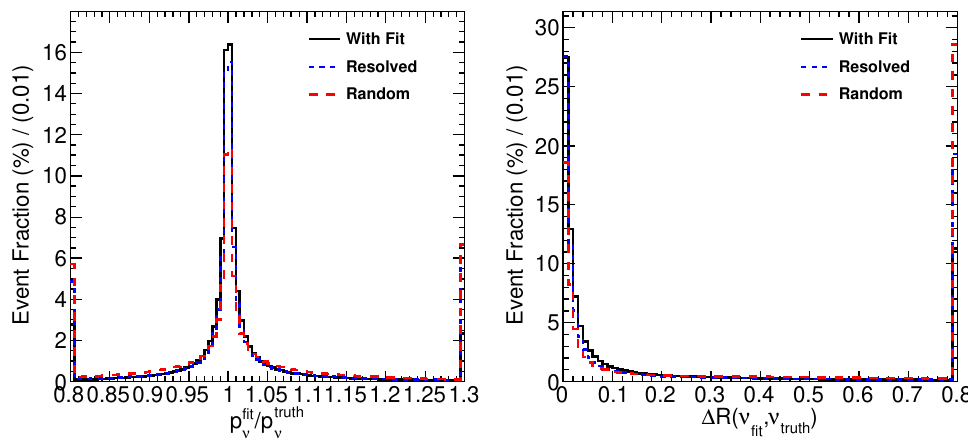
Figure 6 . The ratio of the (cid:12)tted neutrino momentum to the true one (left), and the (cid:1) R distance between them (right), for all ditau decay mode combined. The left and/or right most bins contain the over(cid:13)ows. Three cases are compared: the nominal (cid:12)t based on eq. (2.4) (black solid), the randomly selected solution from the two-fold ambiguity (red dashed), and the solution based on the minimum constraint from eq. (2.4) (blue